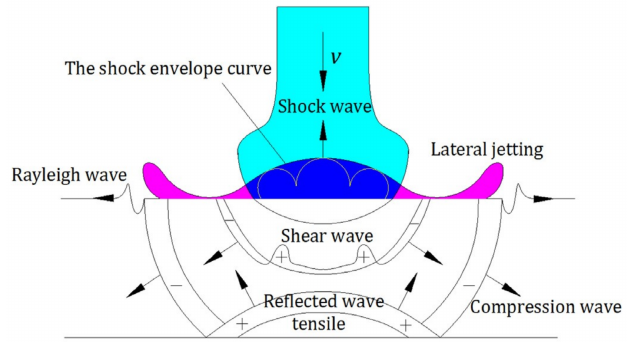
Figure 5. Diagram showing the water jet impact on a solid surface: stress and shock wave generation and